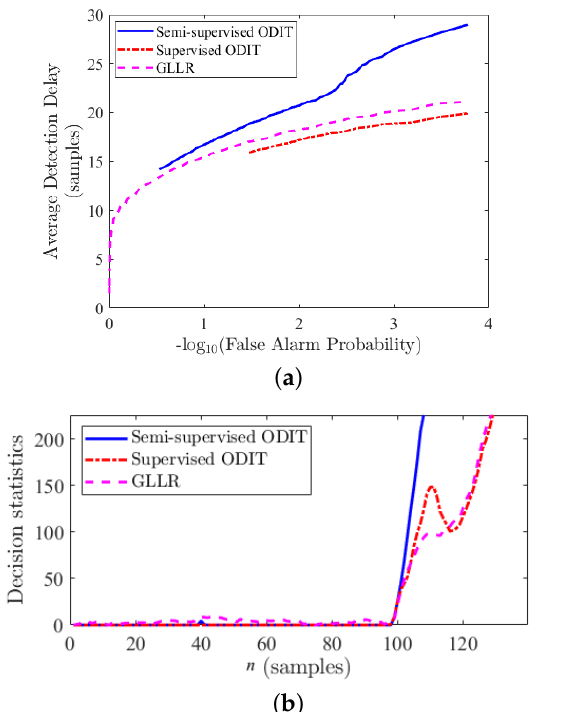
Figure 5. Comparison between the proposed supervised ODIT detector and competing methods GLLR [21] and semi-supervised ODIT [28]. ( a ) Performance comparison averaged over three voltage disturbance types, sag, swell, and oscillatory transients. ( b ) Sample decision statistic for the sag disturbance.